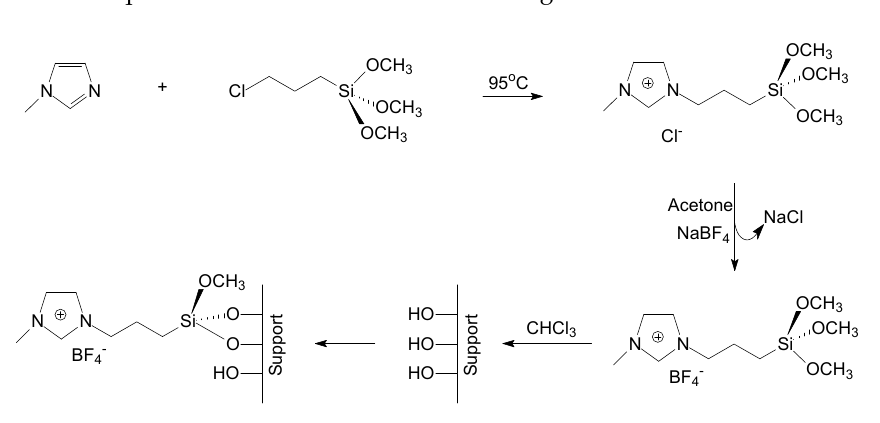
Figure 1. Scheme to synthesis of ionic liquid-modified supports.